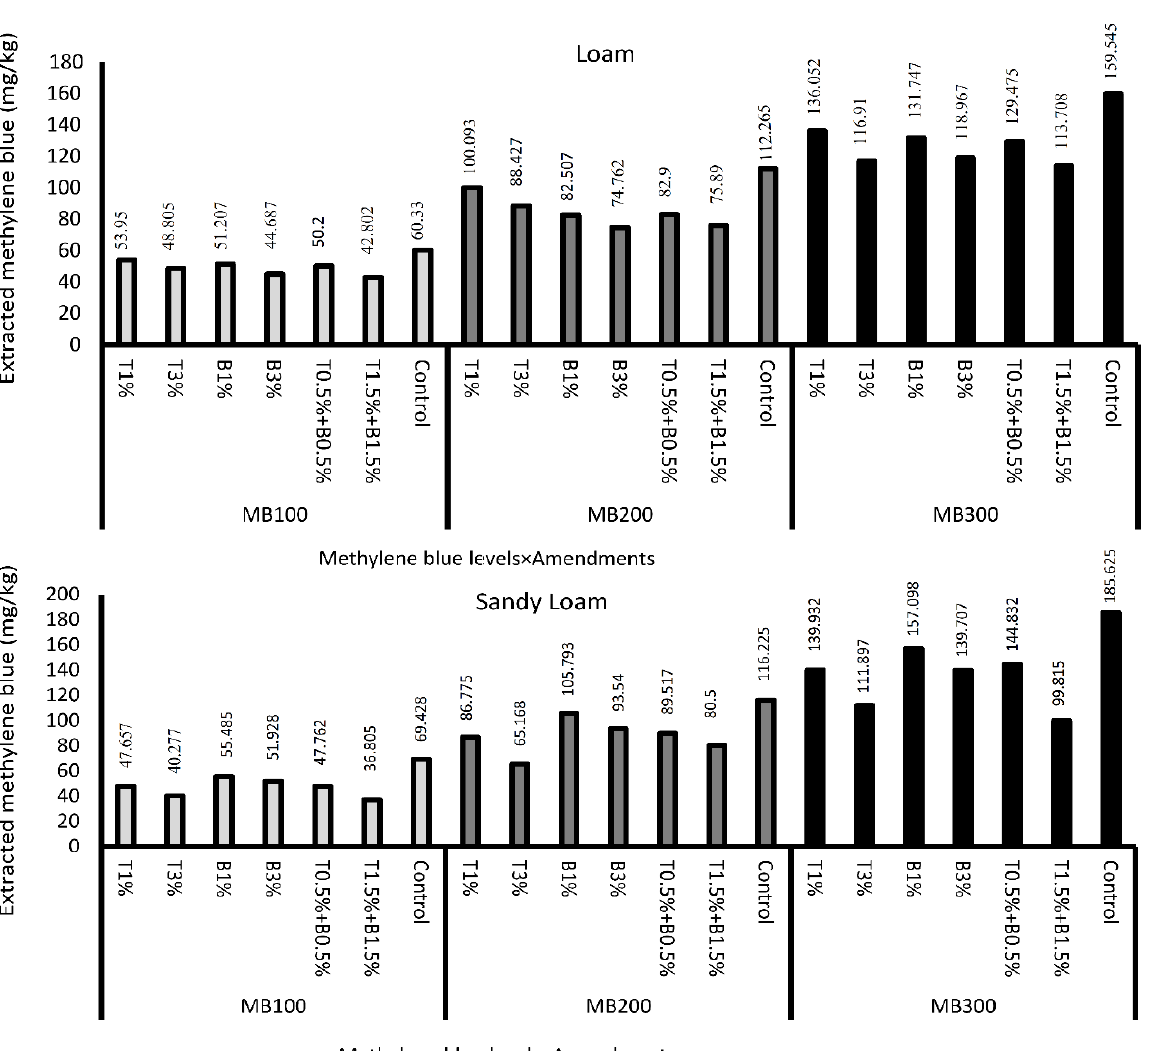
Fig. 5. Effect of MB contamination levels and amendment treatments on extracted MB from SL and L soils (each column with mean of six samples; different letters indicate significant differences in means of different treatments; P<0.05)